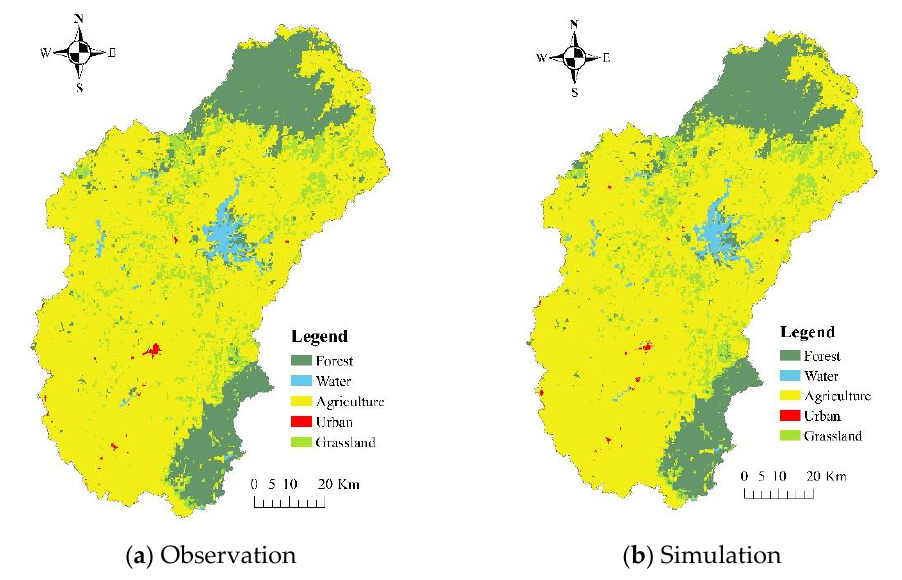
Figure 4. Observed ( a ) and simulated ( b ) LUC maps in 2015 for the study region. The historical trend of LUC changes is supposed to be kept the same for the future.